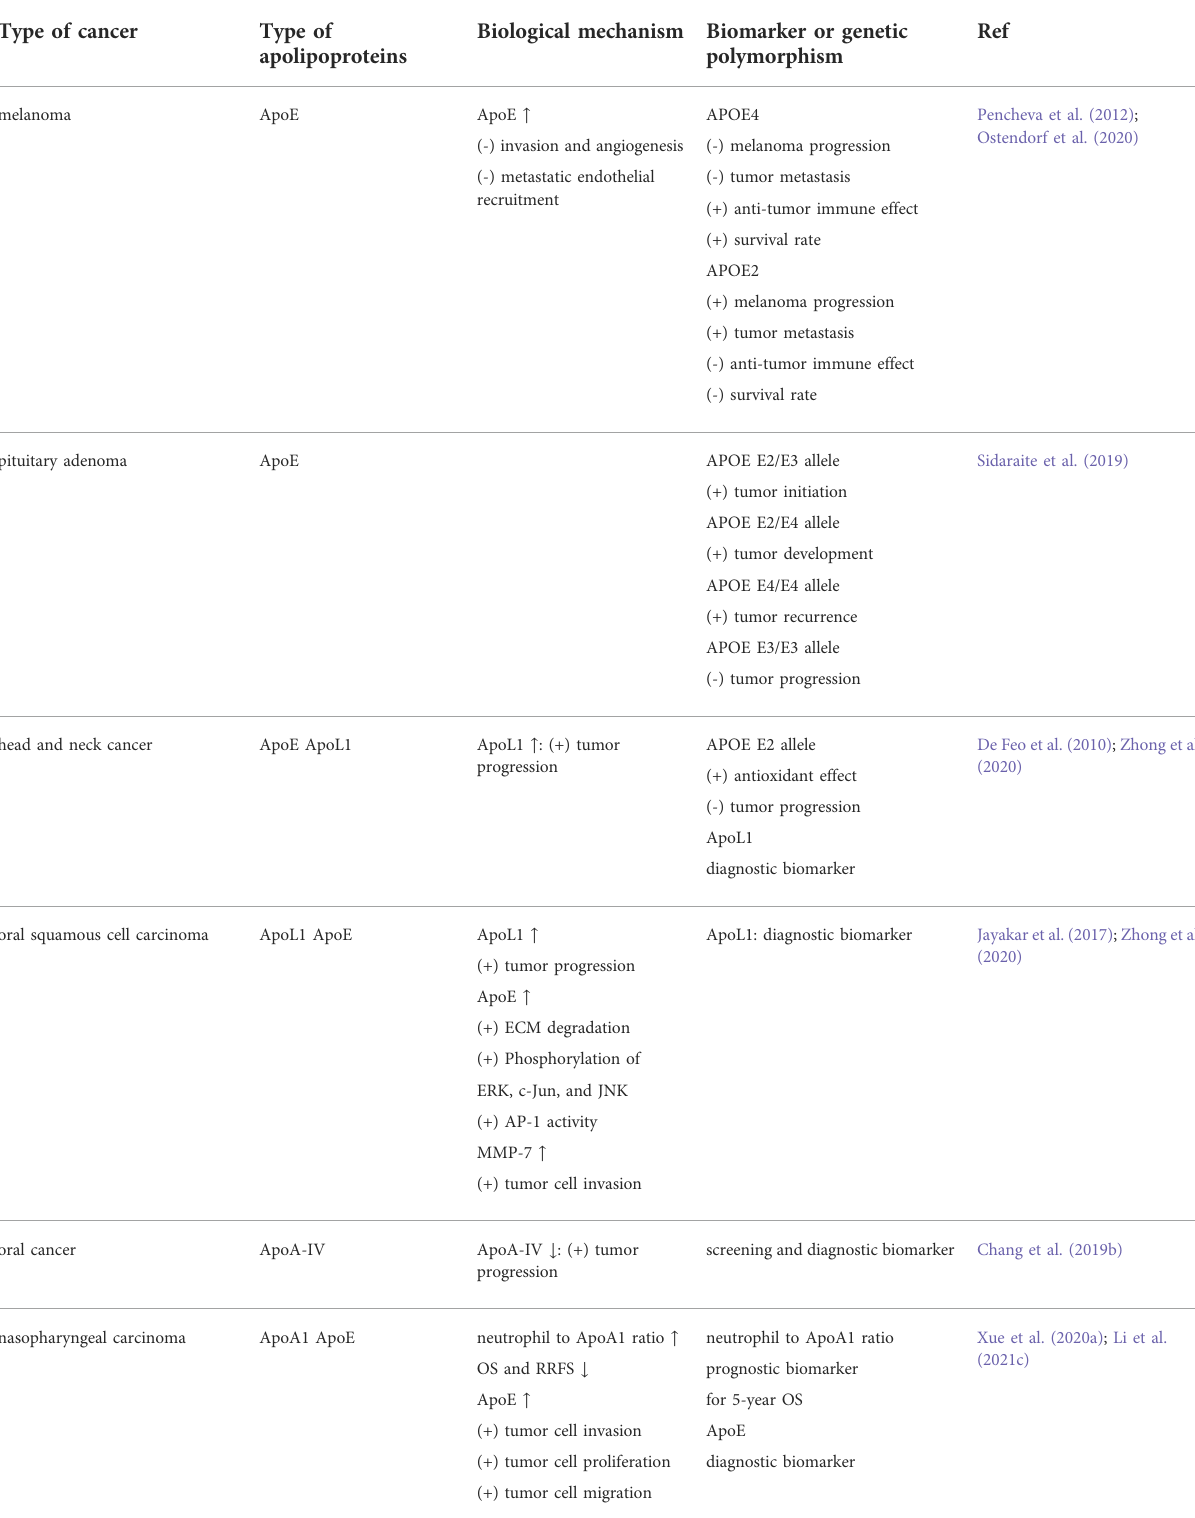
TABLE 1 The participation of APOs in other types of